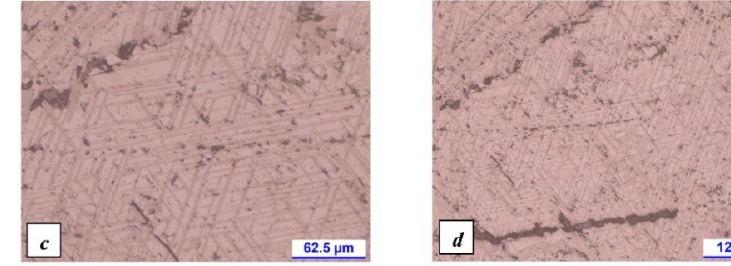
Figure 10. ( a–f ) Photomicrographs of thin cum polished section under the microscope showing dif- ferent minerals and micro-structures [17].